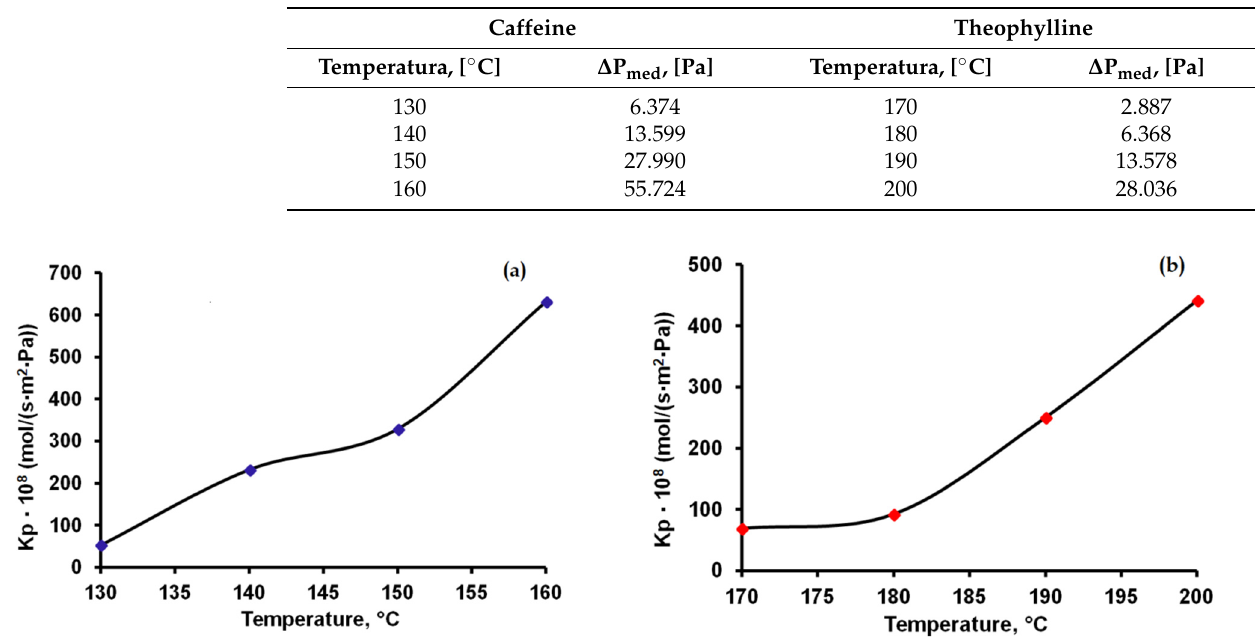
Table 3. Mass transfer potential values at various temperatures.